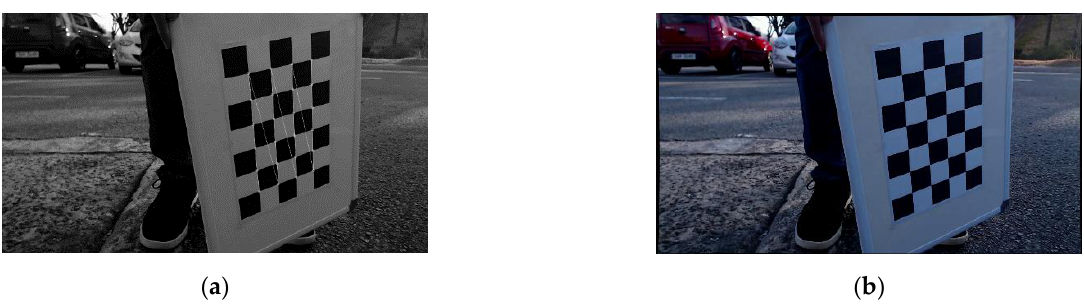
Figure 3. Checkerboard images utilized for distortion correction: ( a ) identification of the corner points in the checkerboard, ( b ) the output image.